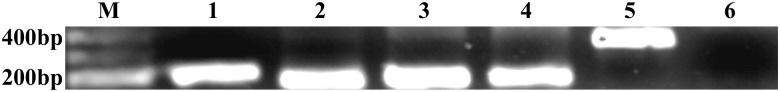
RT-PCR from COS-7 cells transfected with all pSECTAG2A constructions.(M) 1kb Plus DNA ladder. (1) RT-PCR from pSECTAG2A-ag1 transfected cells. (2) RT-PCR from pSECTAG2A-ag2 transfected cells. (3) RT-PCR from pSECTAG2A-ag3 transfected cells. (4) RT-PCR from pSECTAG2A-ag4 transfected cells. (5) RT-PCR from pSECTAG2A-ag5 transfected cells. (6) RT-PCR from pSECTAG2A (empty plasmid) transfected cells.